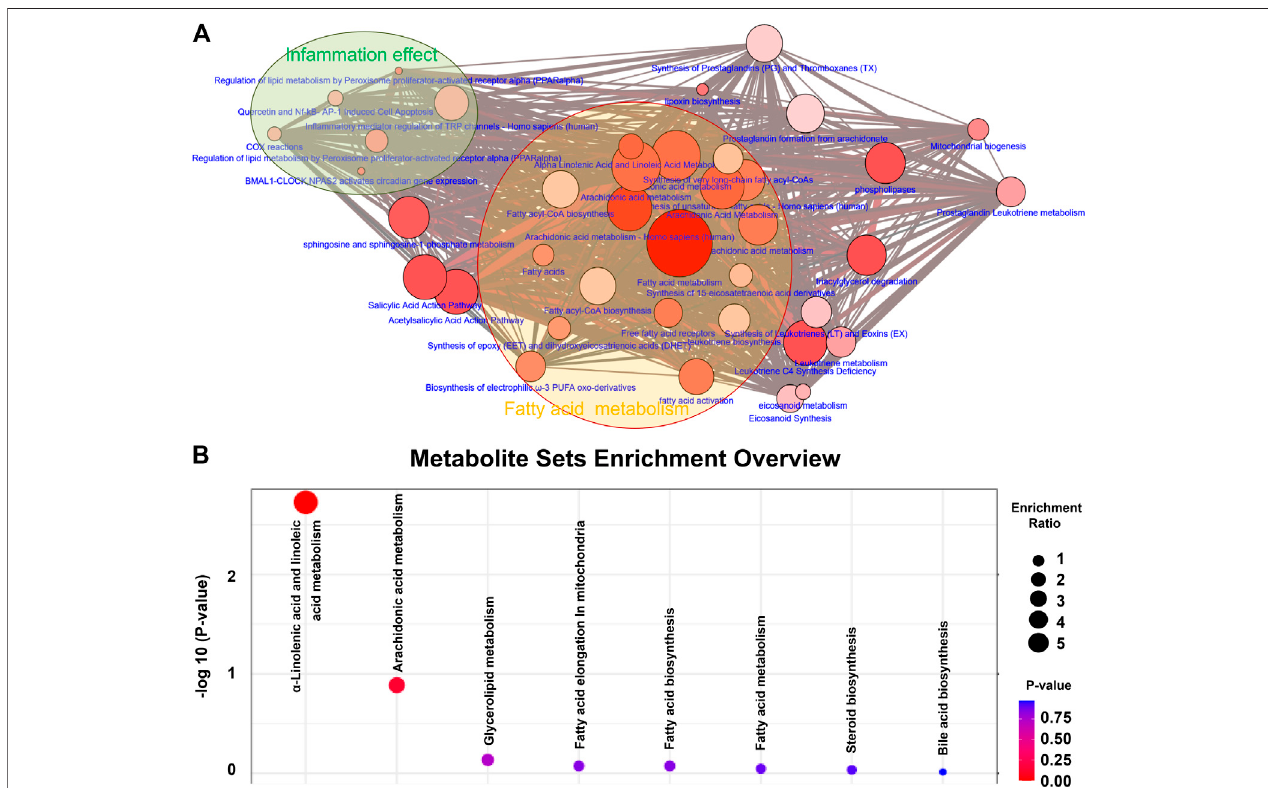
FIGURE 2 | Differential lipid species were associated with fatty acid metabolism. (A) Lipid metabolic networks were constructed by using Cytoscape, Reactome, KEGG and NetPath. Adenine-induced CRF were mainly associated with fatty acid metabolism, arachidonic acid metabolism. (B) Lipid metabolite sets enrichment overview including α -linolenic acid and linoleic acid metabolism, arachidonic acid metabolism, glycerolipid metabolism, fatty acid elongation in mitochondria, fatty acid biosynthesis, fatty acid metabolism, steroid biosynthesis and bile acid biosynthesis. The size and color of each circle is based on enrichment ratio and p -values , respectively. Enrichment ratio is computed by hits/expected, where hits indicates observed hits; expected indicates expected hits.